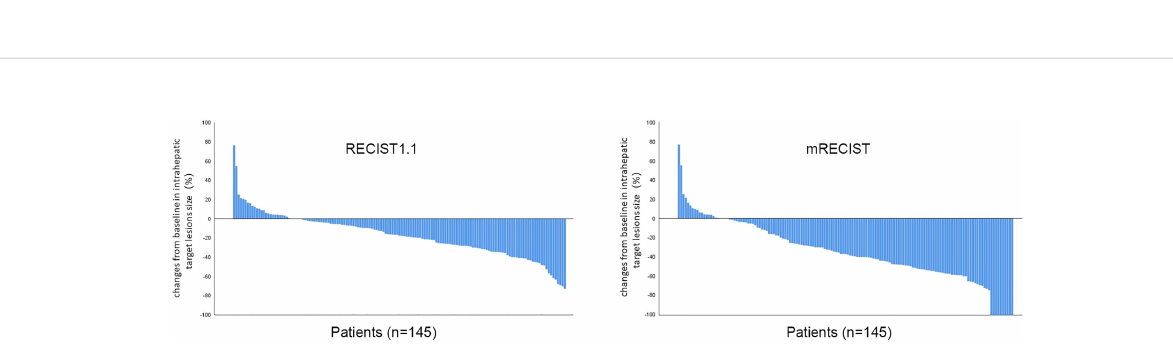
FIGURE 3 Summarized the results of the best response according RECIST1.1 and mRECIST criteria. RECIST1.1, Response Evaluation Criteria in Solid Tumors1.1; mRECIST, modi fi ed Response Evaluation Criteria in Solid